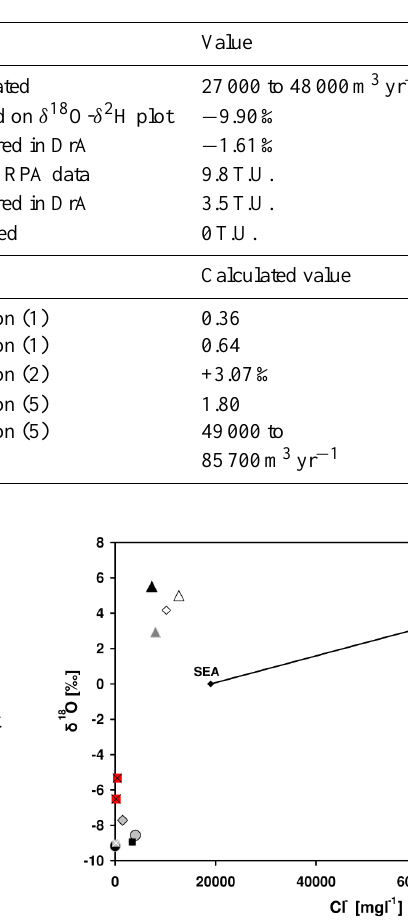
Fig. 8. Cl − - δ 18 O diagram. Point: 2, 4 (Boschetti et al., 2010) – baths; 3a (Conti et al., 2000), 3b and 3c (Capozzi and Picotti, 2010) – mud volcanoes; 5 – common shallow groundwater; 6 (Cervi, 2003), 7 (Venturelli et al., 2003) – springs; 8 – hydrocarbon seep. Black line: evaporation line from